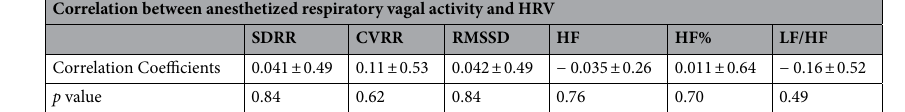
Table 3. Correlations of anesthetized respiratory vagal difference with HRV. Data shown are the averages for six animals (63 total recordings). None of the six HRV metrics have correlations significantly different from zero (Bonferroni corrected significant level of p = 0.0083). Supplemental Table 3 shows individual correlations and p values for each animal.